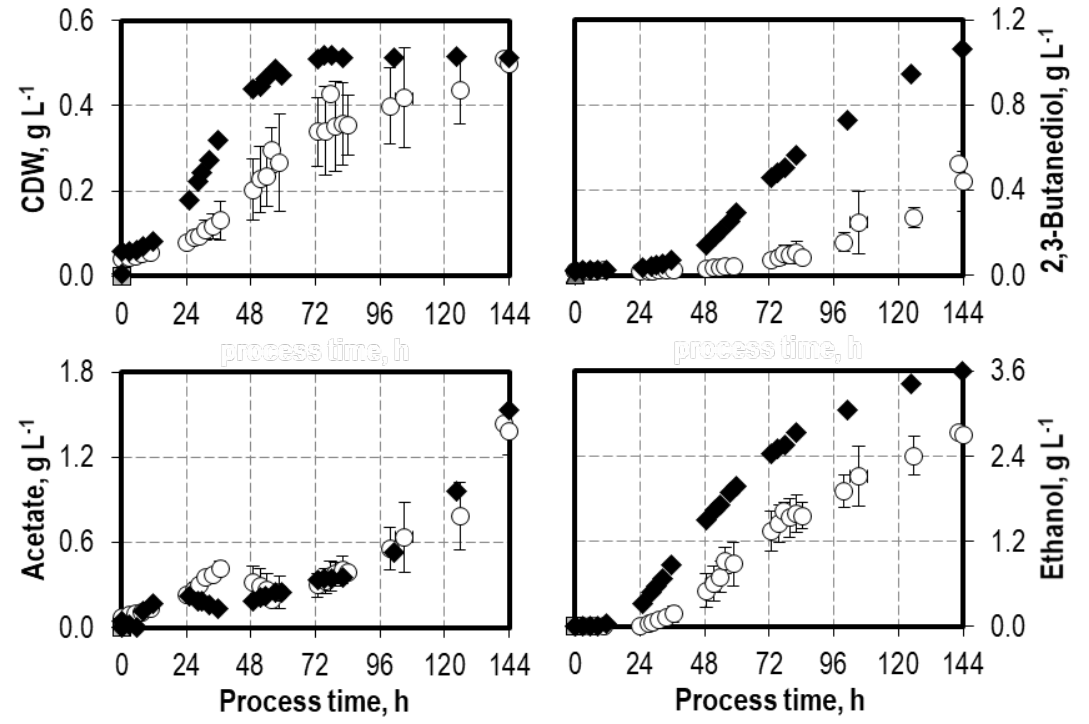
Figure 3. Autotrophic reference batch processes with C. autoethanogenum with artificial syngas (white circle), and batch processes with real syngas from entrained flow gasification of biogenic residues (torrefied wood, TorrCoal) after oxygen reduction by a Pd catalyst (Actisorb O3) (black diamond). Reaction conditions were constant at T = 37 °C, P V − 1 = 15.1 W L − 1 , F gas = 5 NL h − 1 , pH = 6.0 (controlled with 3 M NaOH and 1 M H 2 SO 4 ); p CO = 300 mbar, p H2 = 220 mbar, p CO2 = 90 mbar, p N2 = 390 mbar. Error bars indicate standard deviations of three individual reference batch processes with artificial syngas. The batch process with biogenic syngas was carried out